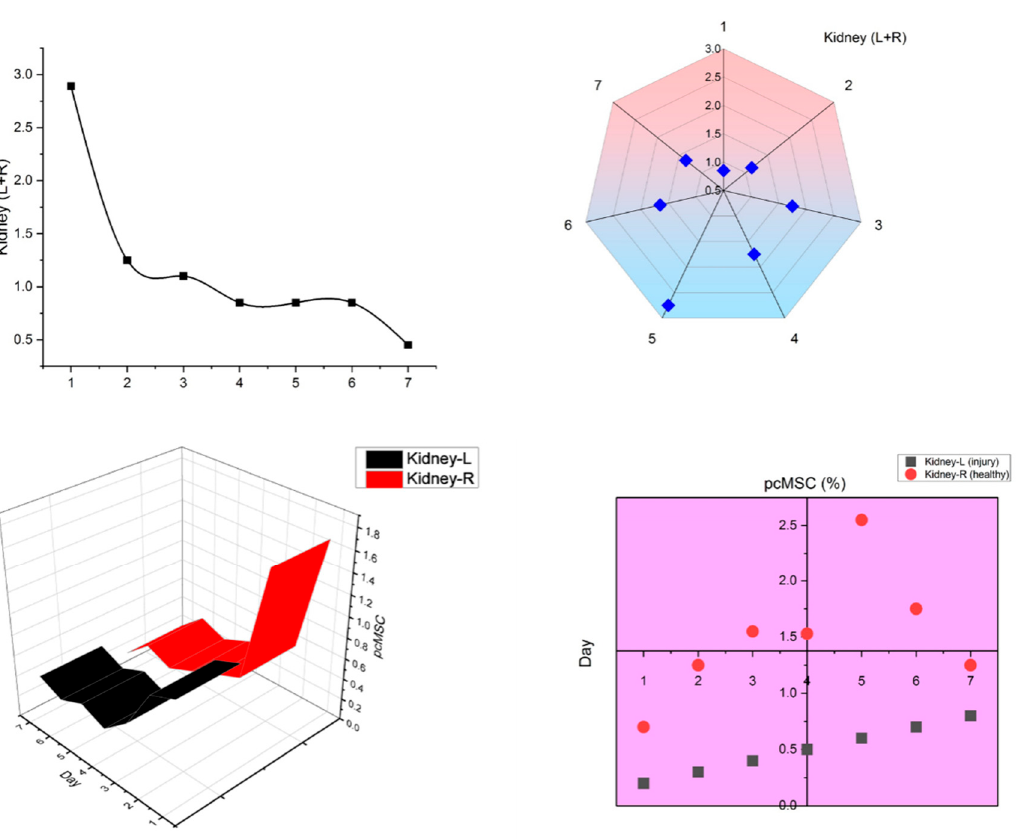
Figure 5. Biodistribution of FND-labeled pcMSCs in the healthy kidney mouse model (red); Biodistribution of FND-labeled pcMSCs in ischemia–reperfusion kidney injury mouse model (black).